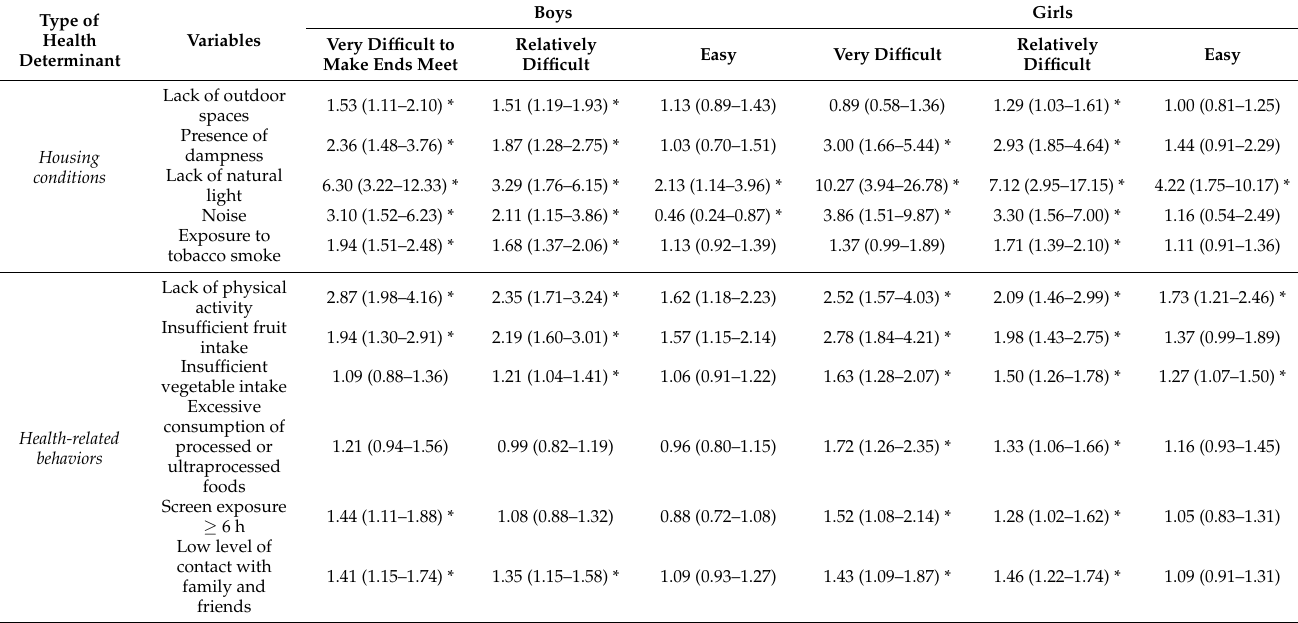
Table 3. Prevalence ratios and 95% CIs for housing conditions and health-related behaviors according to the household’s financial